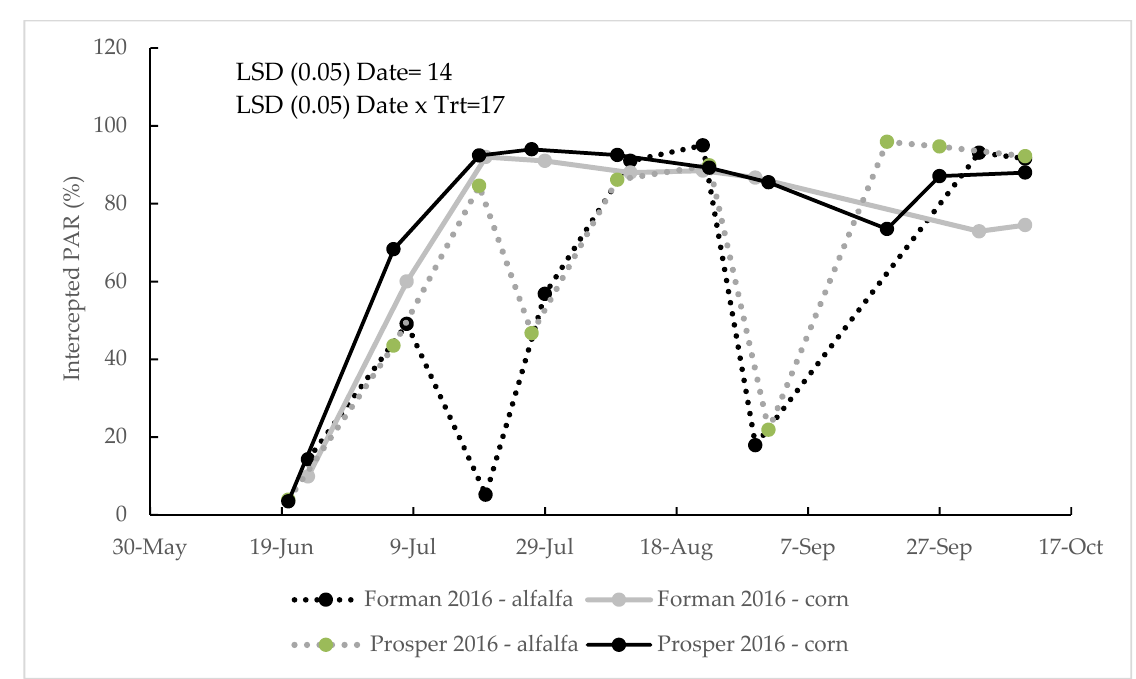
Figure 1. Photosynthetically active radiation (PAR) intercepted by corn (T1) and alfalfa (T2) in monoculture at two locations (Prosper and Forman, ND) in 2016.